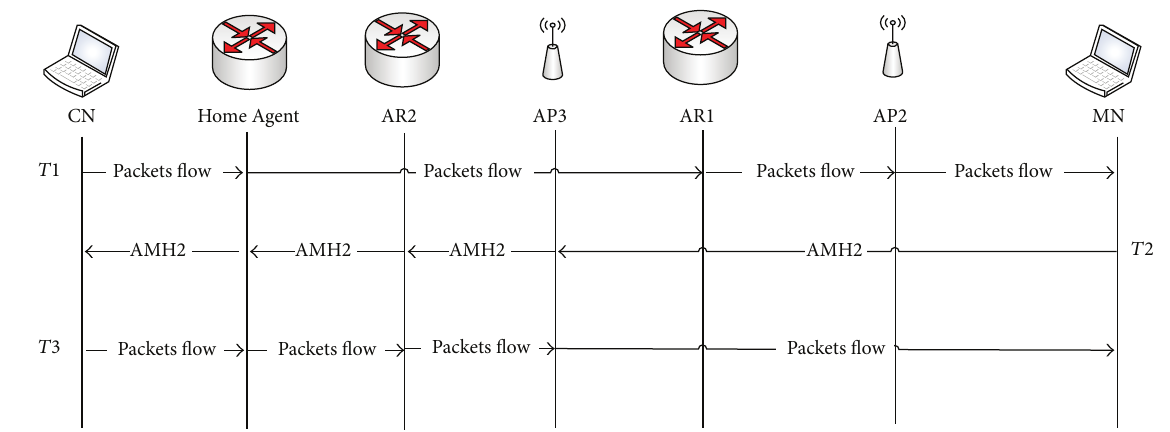
Figure 5: AMH2 scheme within different subnets and the same global routing prefix. Table 3: Data updating in each of AP, AR, HA, and CN after AMH2 message. AP3 entry table after T2 AR2 entry routing table after T2 HA&CN entry routing table after